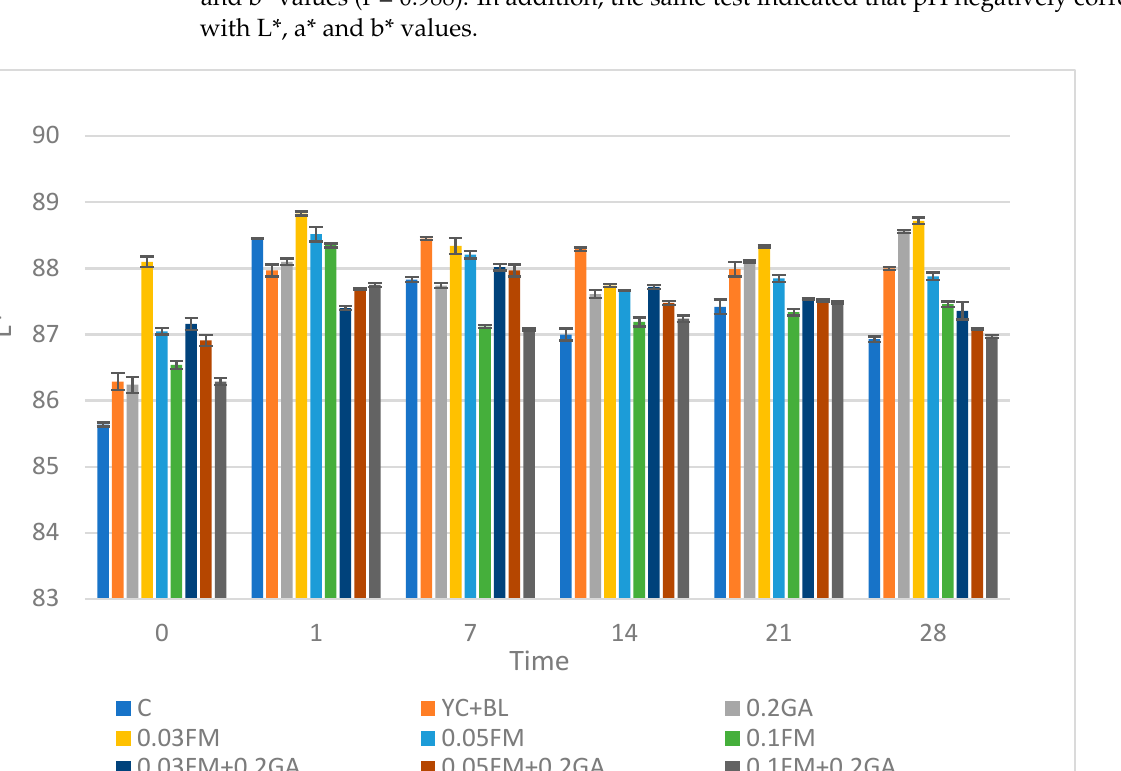
2351 ± 142 c,D Lower case letters show statistical difference among samples at each time at α = 0.05 level. Capital letters show difference among time at each product at α = 0.05 level. 1: 0.02 g KC (control), 2: 0.02 g KC + 0.03 g YC + 0.06 g B. lactis , 3: 0.02 g KC + 0.03 g YC + 0.06 g B. lactis + 0.2 g GA, 4: 0.02 g KC +